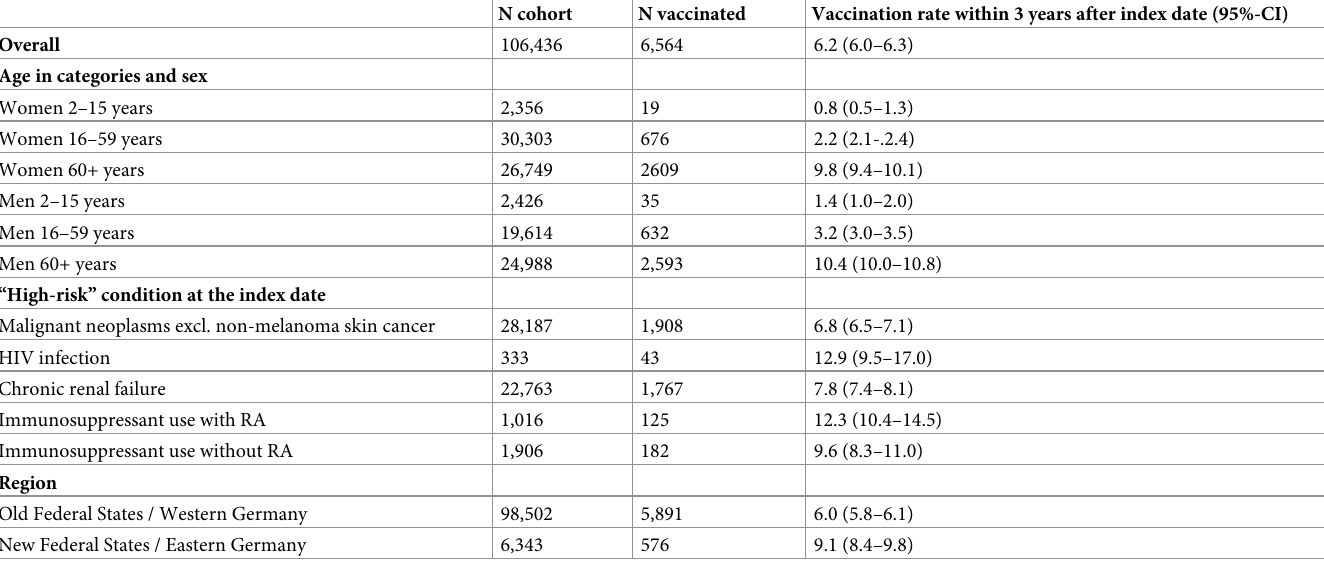
Table 5. Pneumococcal vaccination rates with 95%-confidence intervals within three years in patients with “high-risk” condition for pneumococcal disease. N cohort N vaccinated Vaccination rate within 3 years after index date